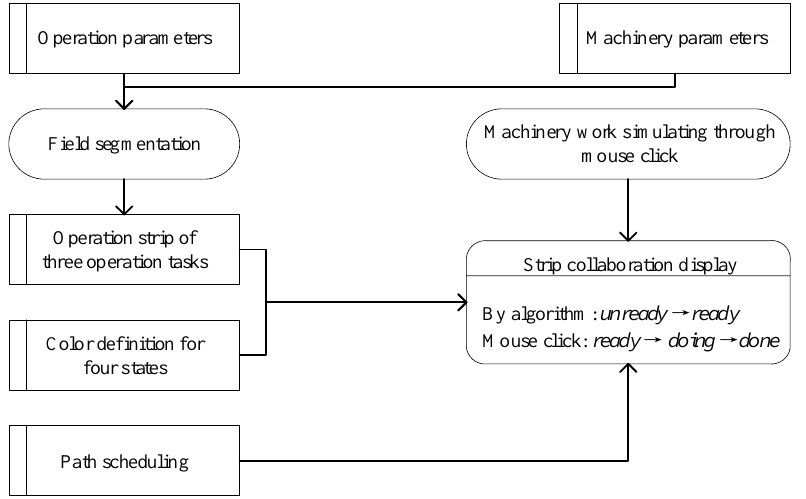
Figure 10. Modules of the simulation model of the collaborative operation.